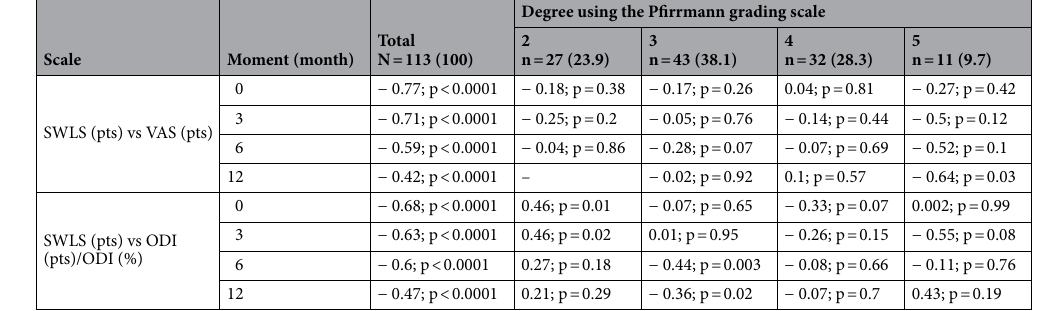
Table 3. The correlation strength of pain intensity according to the VAS scale, degree of disability according to the ODI scale, and quality of life according to the SWLS scale of patients qualified for the microdiscectomy procedure, overall and divided for each radiological degree of advancement of degenerative changes according to the Pfirrmann scale. Data are presented as Spearman’s rank coefficient of correlation; p value using Spearman’s rank correlation